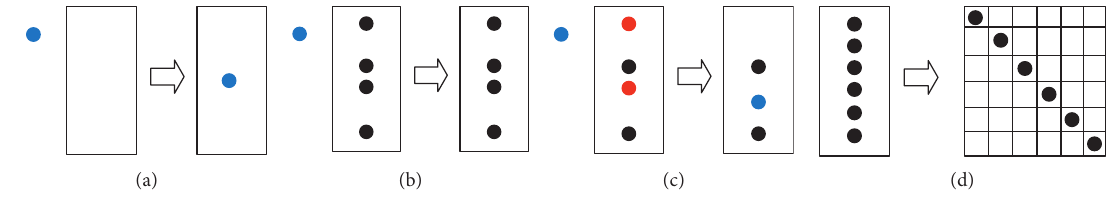
Figure 3: Possible scenarios for repository controlling: (a) scenario 1, (b) scenario 2, (c) scenario 3, and (d) scenario 4.